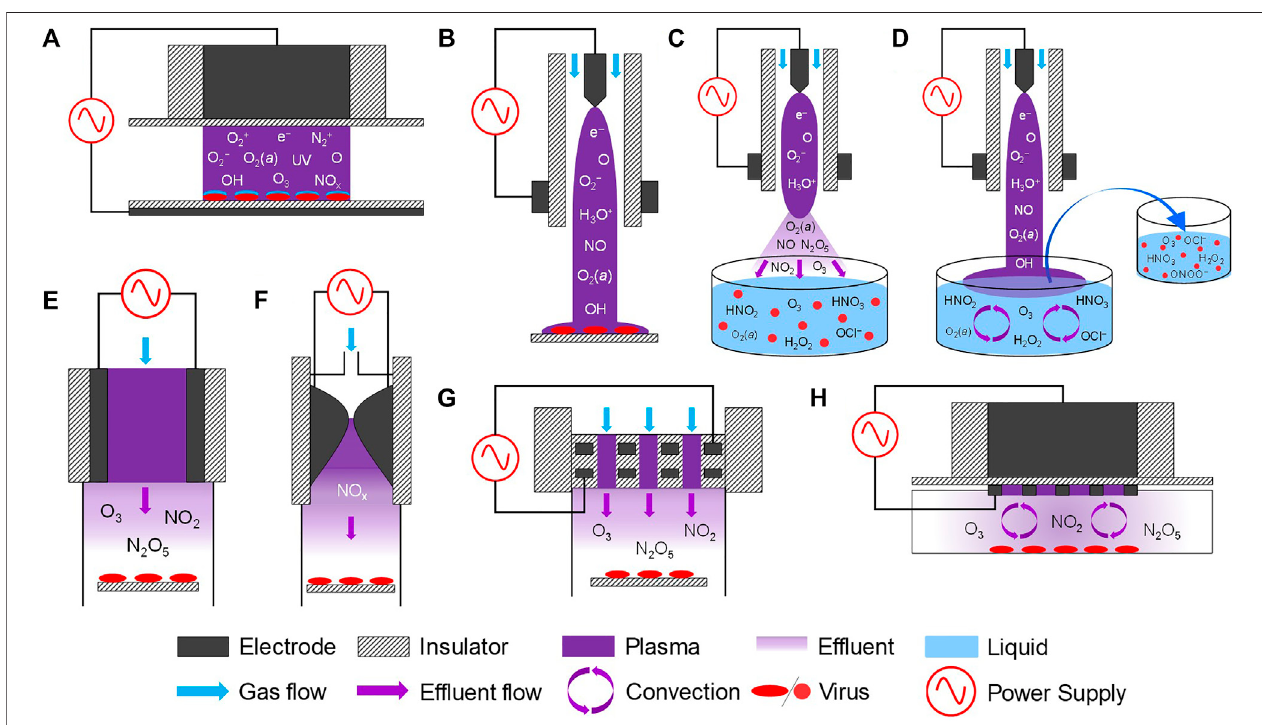
FIGURE6| Schematicofdifferentplasmasourcesusedforvirusinactivationincludingdifferenttreatmentmodalities: (A) DBDfordirecttreatment, (B) plasmajetin contact with a substrate, (C) plasma jet (remote treatment), (D) indirect treatment (PAL/PAM), (E) volumetric DBD (remote treatment), (F) gliding arc (remote treatment), (G) two-dimensional array of integrated coaxial microhollow DBD (remote treatment), and (H) surface DBD (remote treatment). Substrate treated by each of these plasmasourcescouldeitherbeasurfaceoraliquid volume. Thereactivespeciesprovided arethedominantspeciesproduced indryairorO 2 -containingplasmas. Additional species like HNO 2 and H 2 O 2 can be formed for dry substrates when humidity is added to the feed gas.